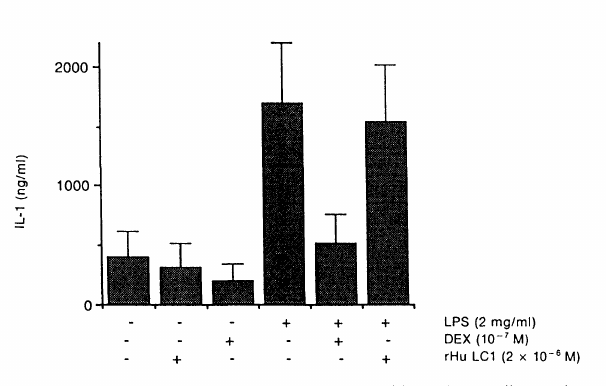
FIG. 2. Monocyte IL-1 fl release: effects of recombinant human lipocortin 1. Peripheral blood monocytes were cultured for 48 h in the presence